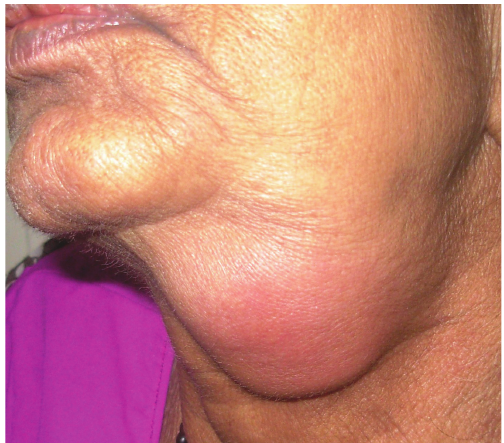
Figure 1: Clinical extraoral photograph of swelling in submandibu- lar region on left side.